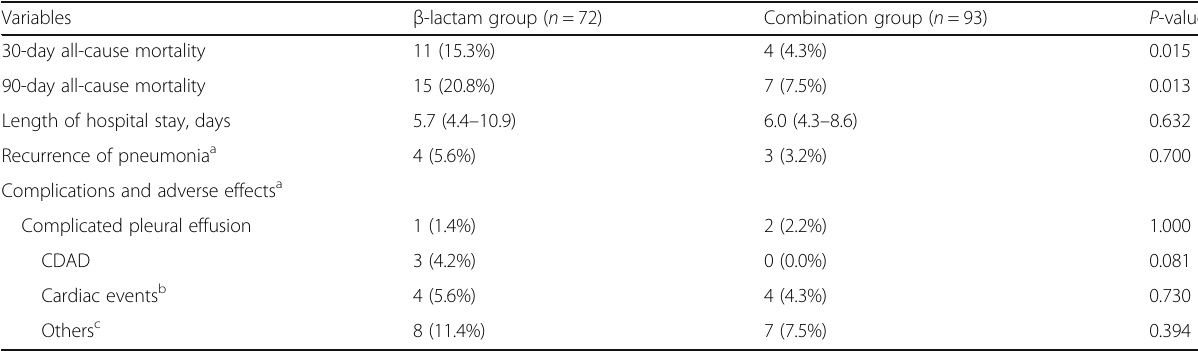
Table 3 Outcomes and complications of patients with neutropenic pneumonia Variables